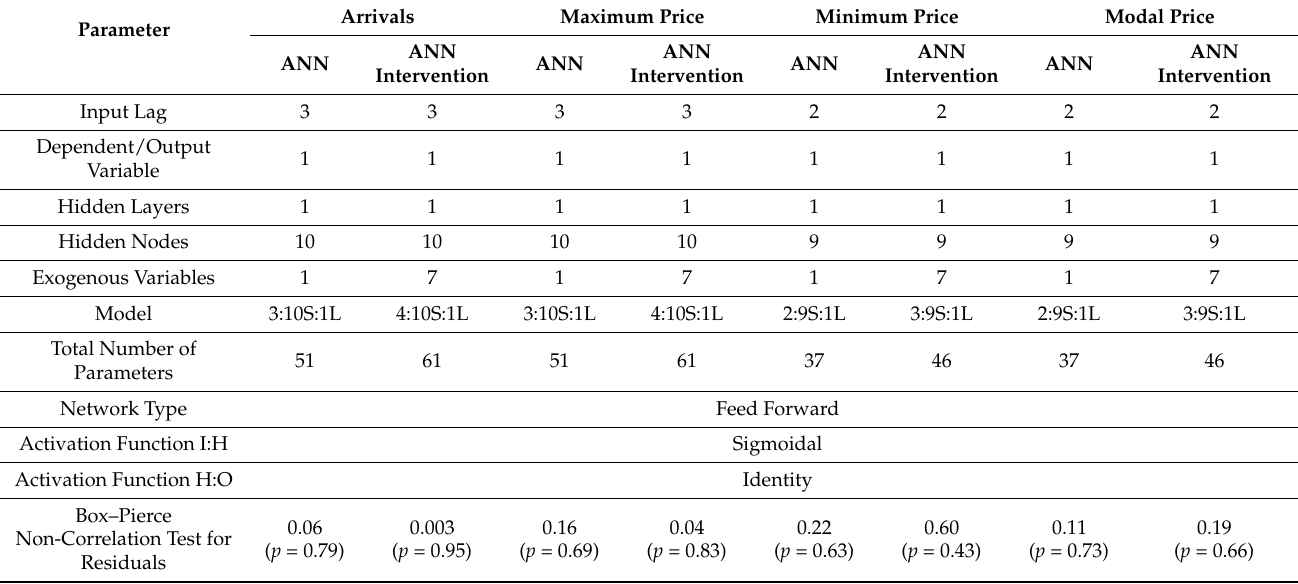
Table 6. Parameter specification of ANN and ANN intervention